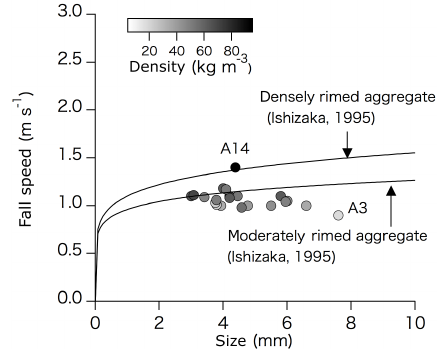
Figure 6. CMF (grey circles) and measured snowfall density of events in the aggregate group and small particle group 1. Density is expressed by greyscale shading in the circles. The two curves represent size–fall speed relationships for densely and moderately rimed aggregates (from Ishizaka,